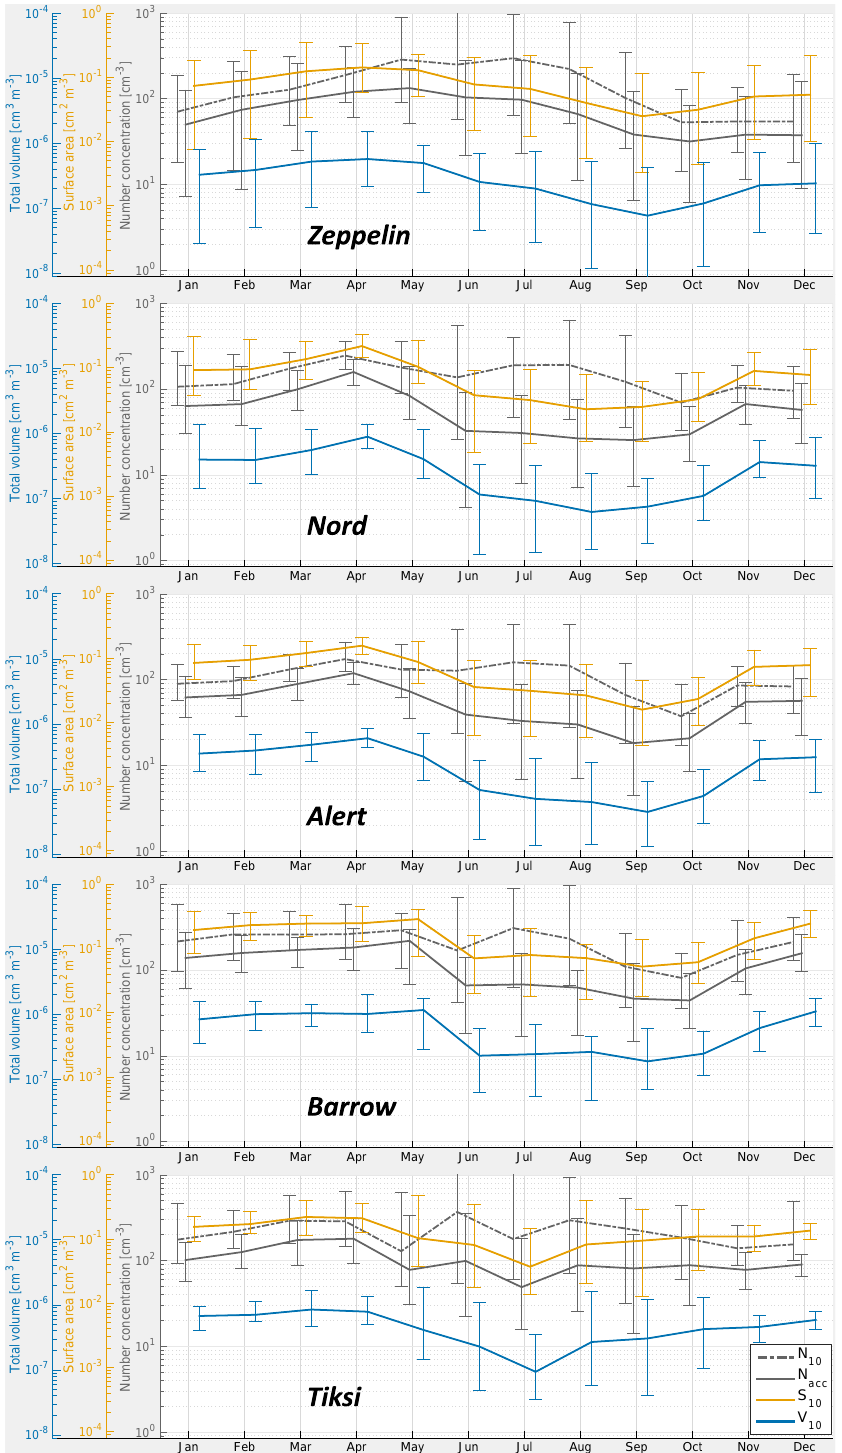
Figure 3. Annual cycle of aerosol bulk properties. The monthly median and interquartile ranges of the aerosol total and accumulation-mode number concentrations are indicated in grey dashed and solid curves and whiskers, respectively. The aerosol total surface area is in orange and the total volume in blue. The total values were calculated for the dry-diameter range of 10 to 500nm, and the accumulation-mode size range is defined here between 100 and 500nm. Particles were assumed spherical for the computation of the aerosol surface area and volume. The colour of the vertical axes and their labels corresponds to the colour of the curves, which are colour-blind